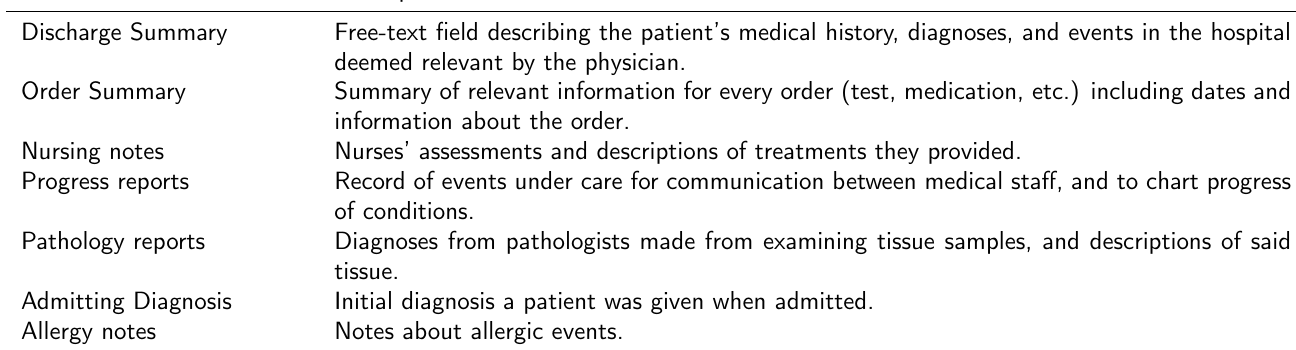
Table 2: Example Elements of Entered Structured